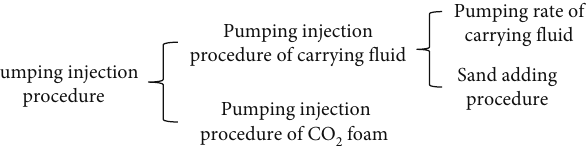
Figure 6: The pumping process of carbon dioxide foam